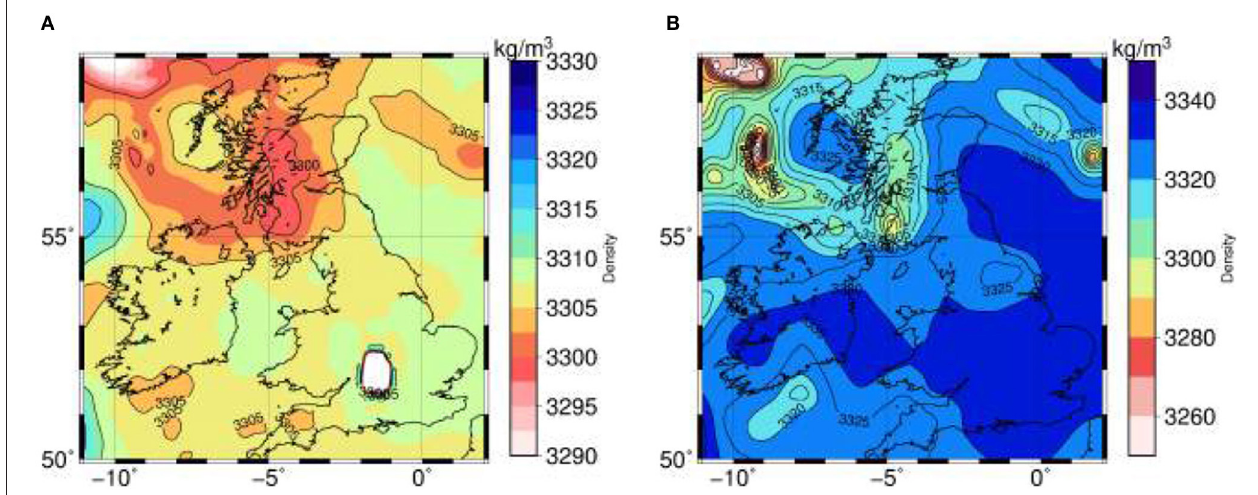
FIGURE 8 | Calculated densities for model M1_s Figure 6 . (A) Density at 42.5 km depth. Note that the white area in Great Britain corresponds to crustal material. (B) Density at 68.5 km